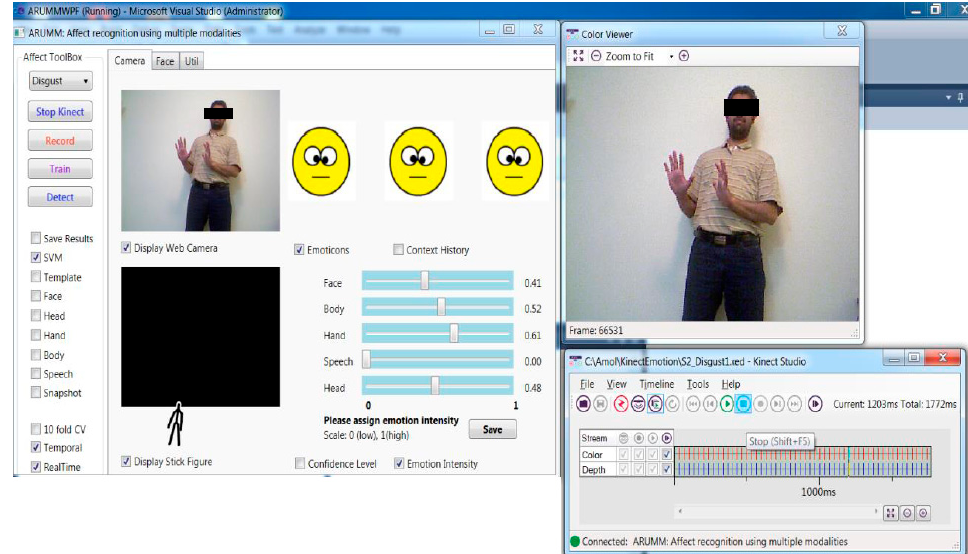
Figure 1. Implementation of multimodal affect recognition system.